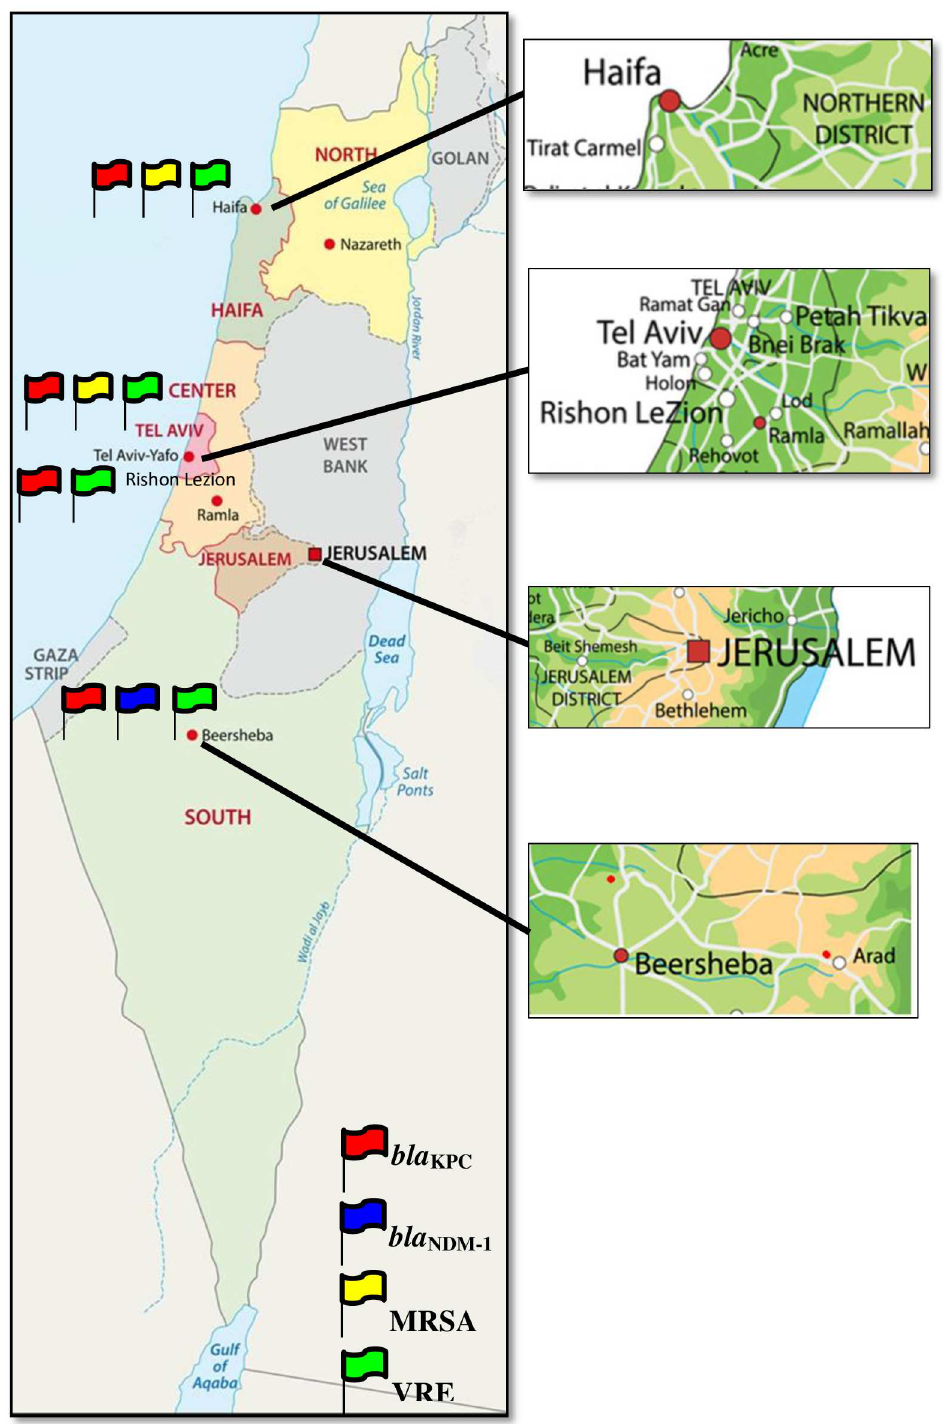
Fig 1. A map of the whole state of Israel illustrating sewage sampling locations. Each location is marked with flags indicatingthe pan-resistant bacteria found in that location. A magnification of the four main districts is displayedon the right side of the figure. Maps illustrated by "Fotolia by Adobe" (https://www.fotolia. com/).